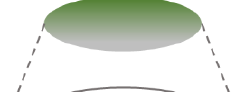
. Figure 2 . Three kinds of mechanisms; green circles depict the phenomenon to be explained (adapted from [3], p. 66) [3]. Our project in this manuscript is to examine how different kinds of mechanistic explanations act in concert in pharmacology. For the current purposes, we shall focus on producing and underlying mechanisms. An elaborate discussion of maintaining mechanisms demands for a project of its own. 2.2. Producing and Underlying The distinction between producing and underlying mechanisms mirrors the familiar distinctions between etiological and constitutive explanations [18]. Still, there is more to this distinction than assuming a different phenomenon–mechanism relation: explanations describing producing and underlying mechanisms, respectively, have different explananda, i.e., end-products or overall processes. With this in mind, there are two straightforward rationalizations/descriptions as to how